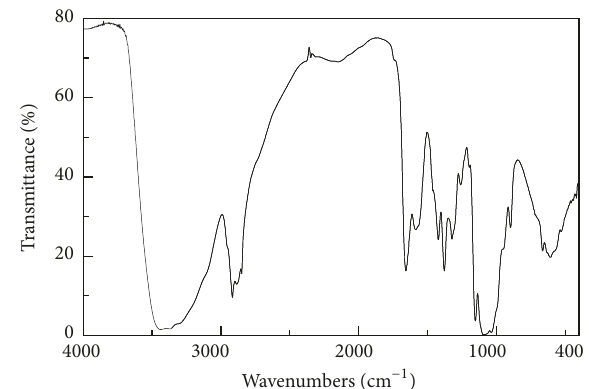
Figure 2: FTIR spectra of hybrid membrane of carboxymethyl chitosan and silicon